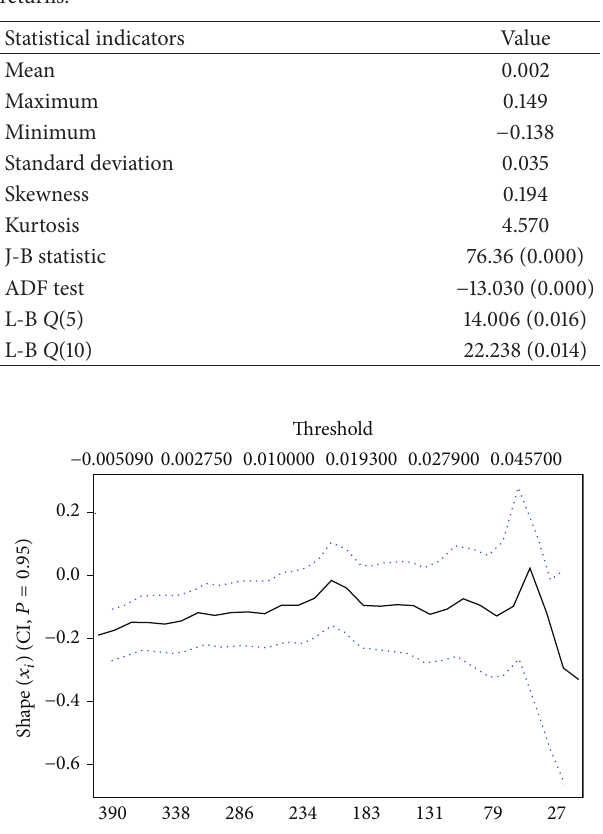
Table 1: Statistical characteristics of shanghai composite index returns.